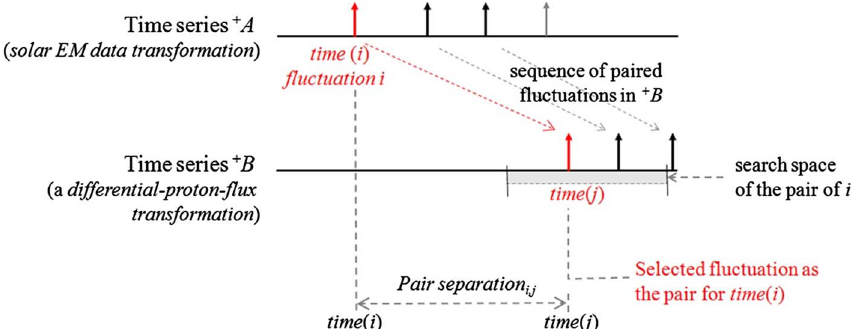
Fig. 1. This fi gure shows two bit-based series. The “ 1s ” of the top time series shows extreme values from 5-min averaged EUV-based data. The “ 1s ” of the bottom time series is extreme time derivatives from a 5-min differential proton fl ux. This fi gure also shows the identi fi cation of three “ cause-consequence ” pairs. A pair, shown in red, is composed of a “ 1 ” at time (i) of the top time series and a “ 1 ” at time (j) in the bottom time series, and the corresponding